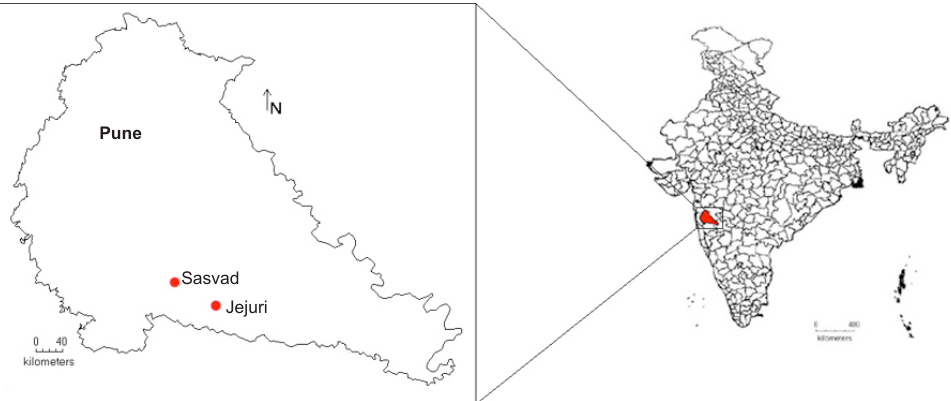
Figure 1. The study area of Saswad and Jejuri, Taluka Purandar, Pune District, Maharashtra is shown in